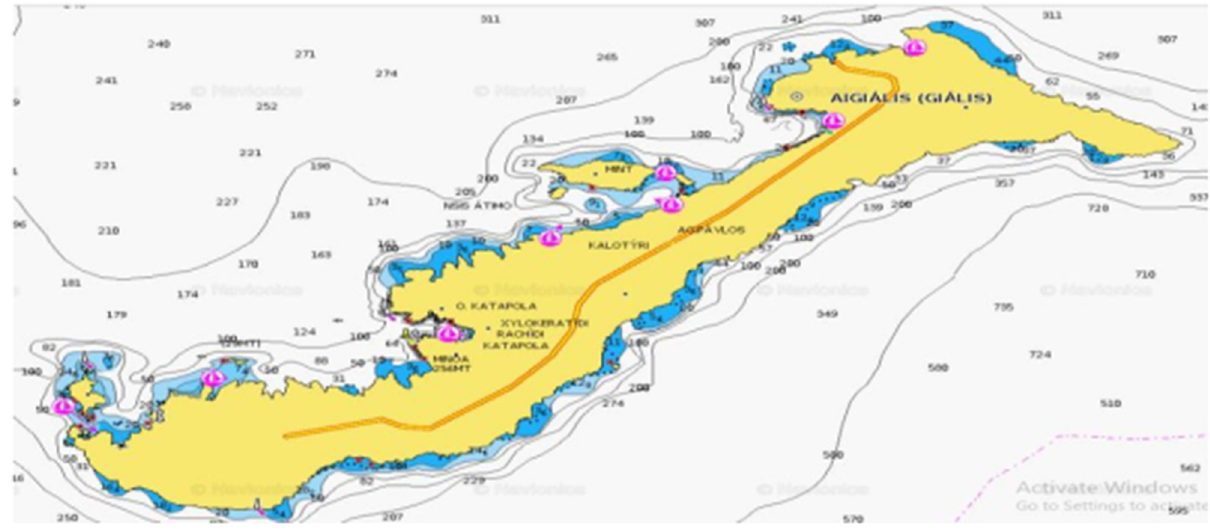
Fig. 6. Bathymetric map of Amorgos